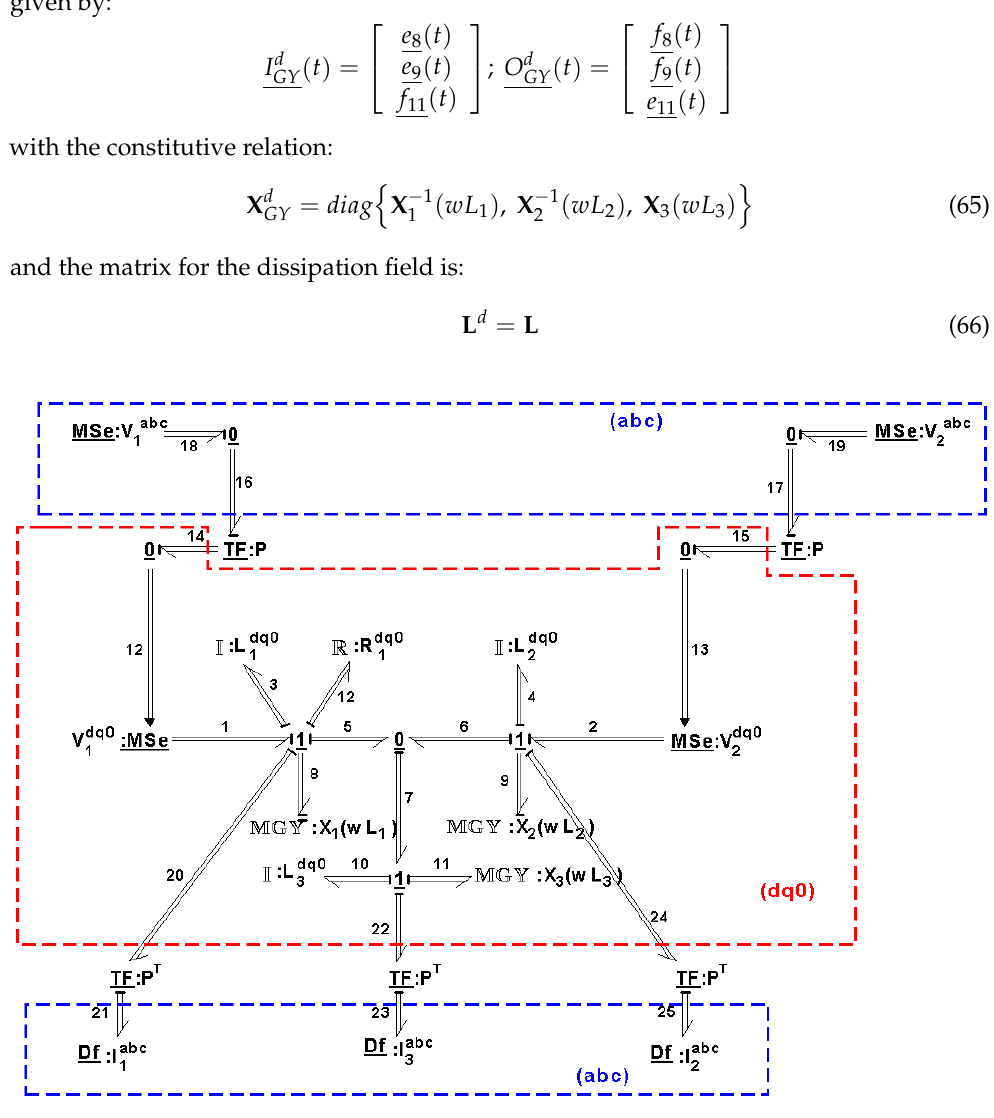
Figure 13. MBGD of the electrical